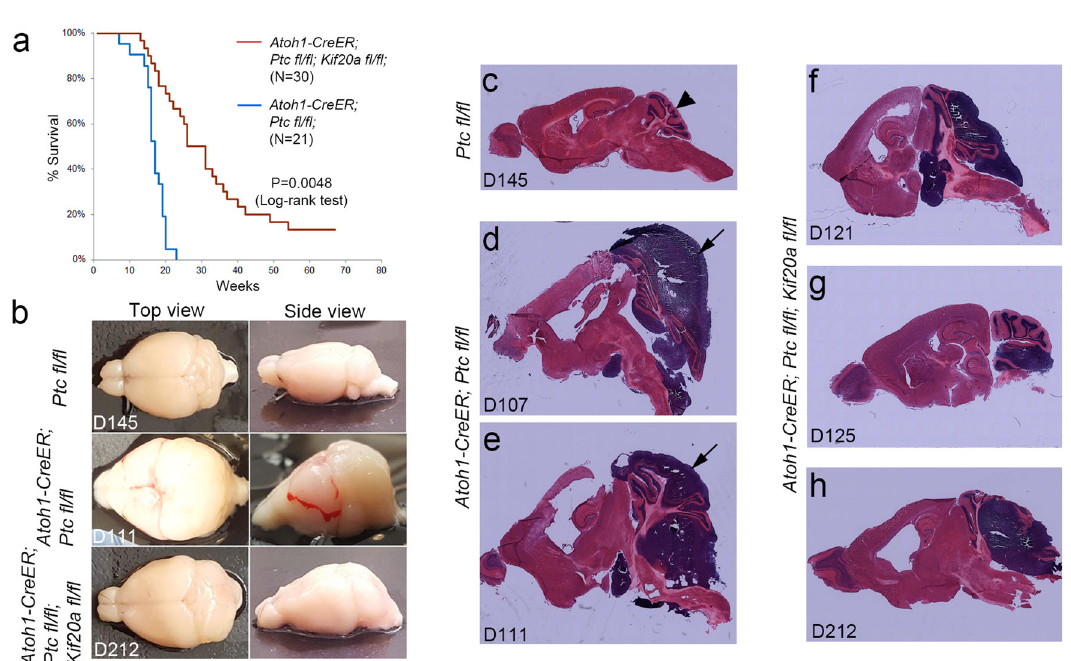
Fig. 3 LOF of KIF20A in tumor-initiating GNPs inhibits SHH-induced MB formation. a Single ( Atoh1-CreER; Ptc fl / fl )- and double ( Atoh1-CreER; Ptc fl / fl ; Kif20a fl / fl )-knockout mice were treated with tamoxifen at P4 by gavage. Brain samples were collected for analyses when brain tumor symptoms were developed. Survival of mice was summarized in the Kaplan – Meier curve. b Representative whole brain samples from wild-type ( Ptc fl / fl ), Ptc single ( Atoh1- CreER; Ptc fl / fl )-, or Ptc/Kif20a double ( Atoh1-CreER; Ptc fl / fl ; Kif20a fl / fl )-knockout mice. Numbers in each panel indicate the days when brain samples were collected after TM injection (sections of these brains were shown in c – h ). c Normal brain features from section of wild-type control ( Ptc fl / fl ) brain collected 145 days after TM injection. Arrowhead indicates the cerebellum. d , e Examples of sections from Ptc single-knockout mice displayed strong tumor growth and often disformed brain structures. Arrows indicate the tumor mass. f – h Examples of sections from Ptc/Kif20a double mice displayed varied tumor sizes. The overall brain structures were in general in better shape than the single-knockout